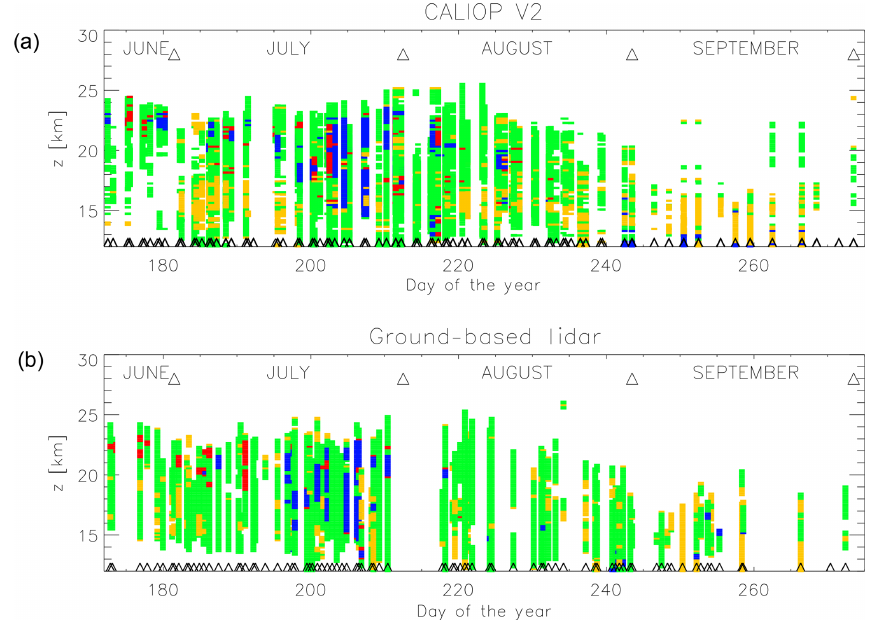
Figure 2. PSC observations recorded in 2006 above McMurdo. (a) CALIOP around McMurdo from v2 product. (b) Ground-based lidar data. The PSC classes are represented by colors; green denotes NAT mixtures, orange denotes STS, blue denotes ice and red denotes enhanced NAT mixtures. Triangles on the x axis indicate the days when at least one observation was